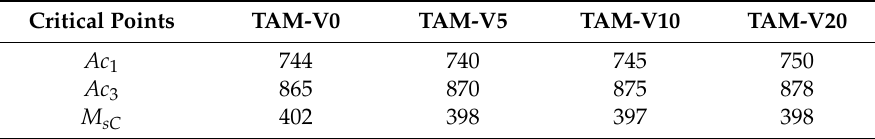
Table 2. Critical points measured by dilatometer and the calculated Ms C / ◦ C.